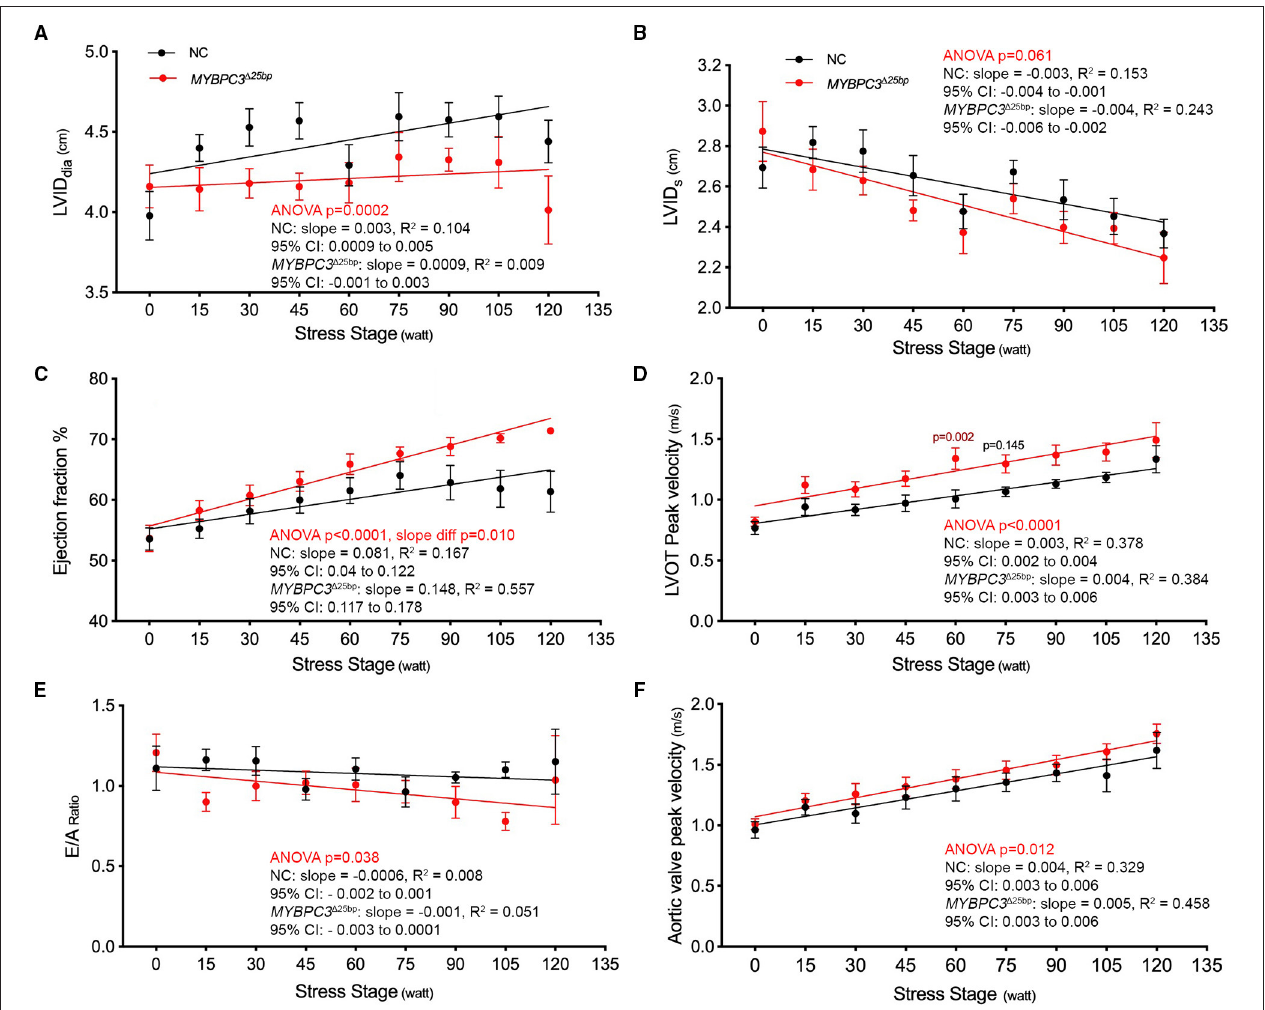
FIGURE 4 | Prevalent South Asian-specific MYBPC3 1 25bp variant is associated with hypercontraction and impaired relaxation under exercise stress (10 NCs vs. 10 MYBPC3 1 25bp carriers). (A) A significant difference in LVID dia is observed between carriers of the MYBPC3 1 25bp variant and NCs (Two-way ANOVA, p = 0.0002; CI: 0.239 ± 0.125). In response to stress, LVID dia increases significantly from baseline in NCs, whereas it does not significantly change in MYBPC3 1 25bp carriers. (B) The graph depicts a non-significant difference between MYBPC3 1 25bp variant carriers and NCs in LVID s in response to stress (Two-way ANOVA, p = 0.061; CI: 0.09